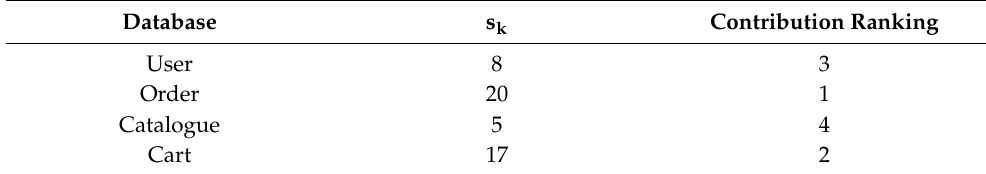
Table 15. s k and contribution ranking of databases in